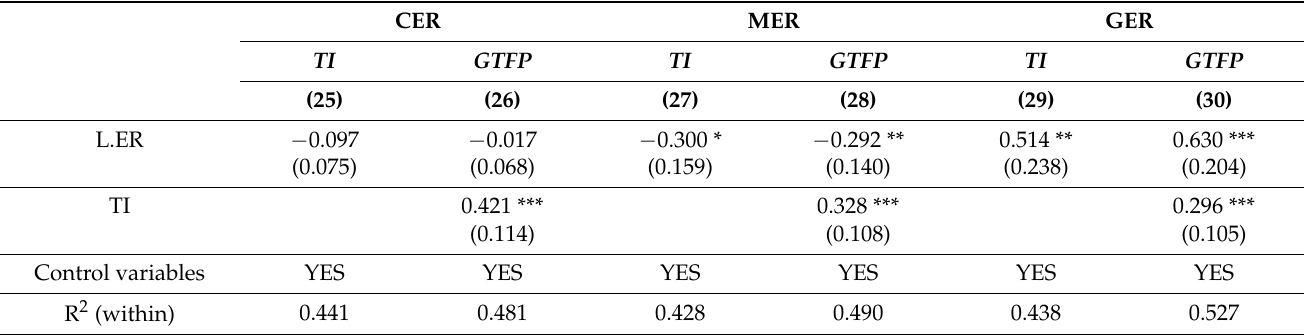
Table 7. Intermediary effect of technological innovation (Fixed effect